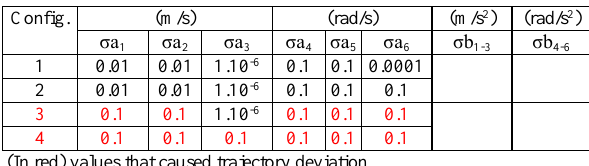
Table 3. Variation in the standard deviations of the polynomial parameters related to speed in the XYZ and